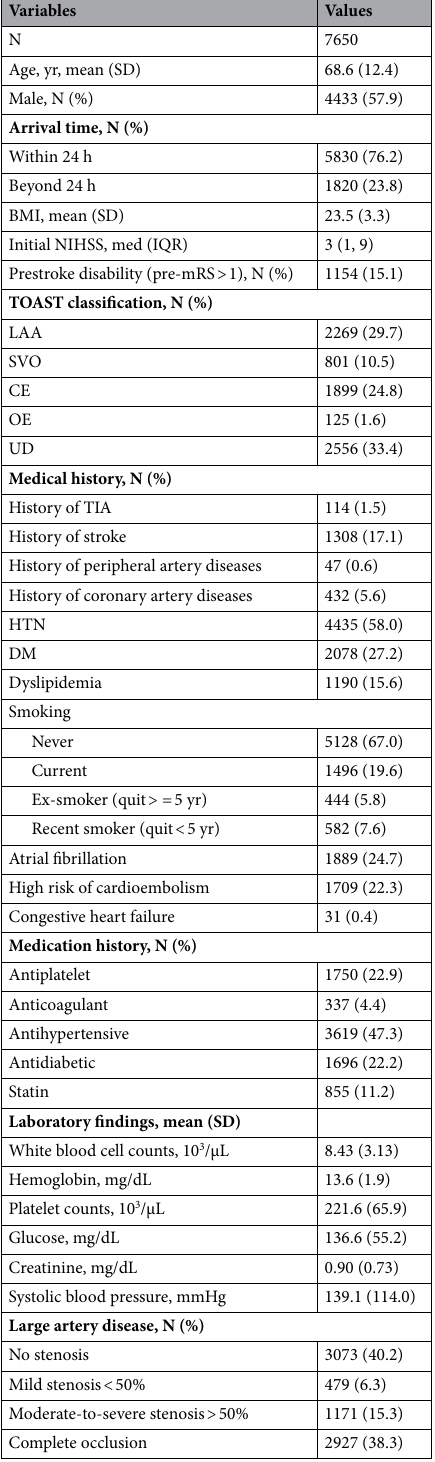
Table 1. General characteristics of subjects. BMI; body mass index, NIHSS; National Institutes of Health Stroke Scale, TOAST; Trials of